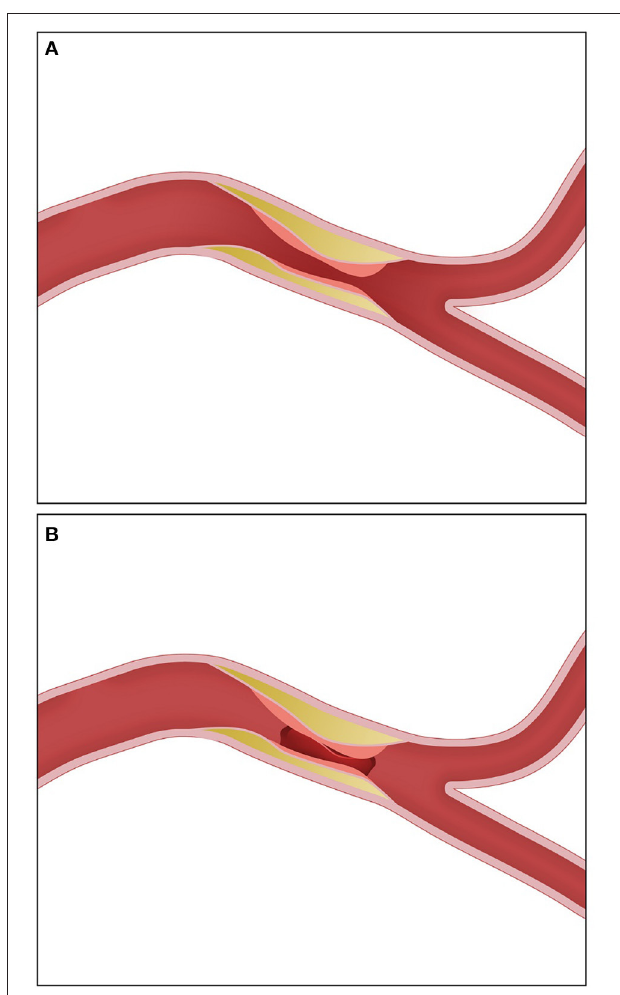
FIGURE 2 | Post-thrombectomy angiographic appearance in ICAS-related ELVO requiring rescue therapy. (A) Severe residual stenosis. (B) Re-occlusion. ICAS, intracranial atherosclerosis; ELVO, emergent large vessel